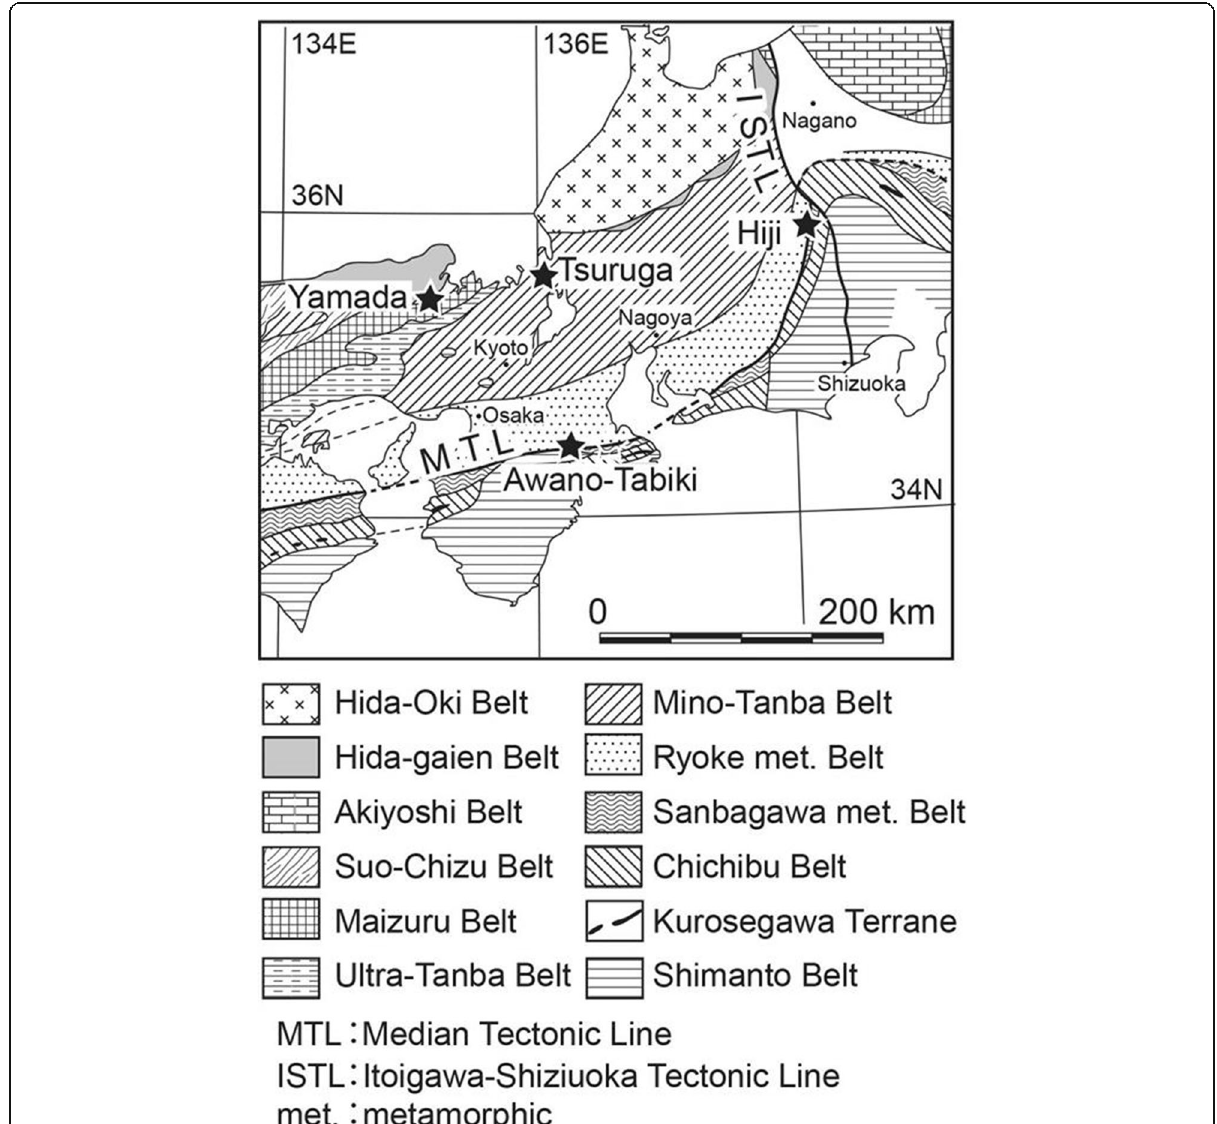
Fig. 1 Simplified geotectonic map showing the location of the study area around the MTL and the Tsuruga and Yamada faults. The stars denote the approximate locations where the samples were collected (see Fig. 2 for further details on each sample